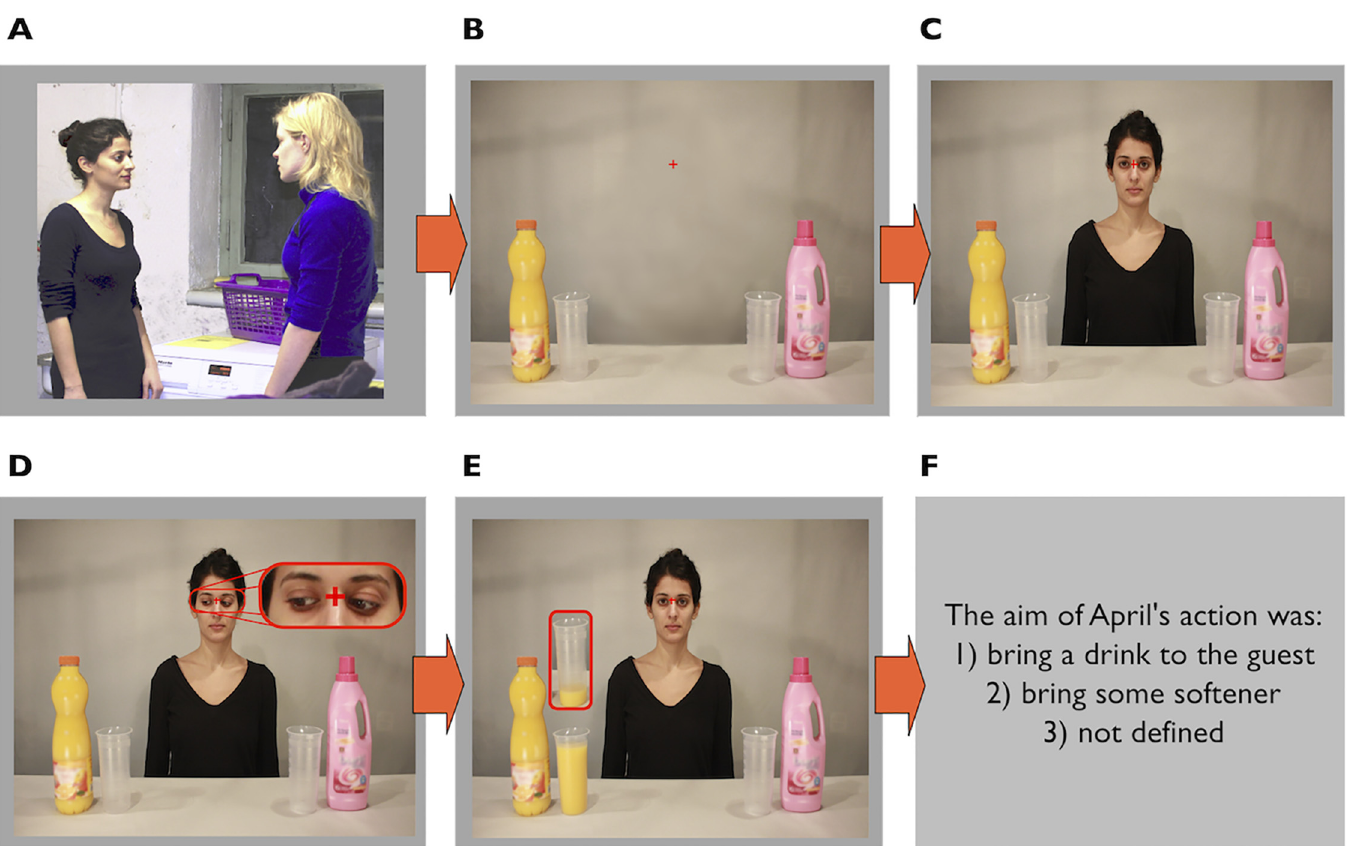
Fig 1. Schematic representation of an example trial in Experiment 1, depicting a ‘ laundry ’ context with an incongruent gaze direction and a validly cued target. Gaze direction in Frame D is zoomed-in only for the purpose of illustration. Frame E shows both the target with a low level of liquid as well as the target with high level of liquid. These targets are presented together only for illustration purposes; in the experiment proper, only one of the two targets was presented.